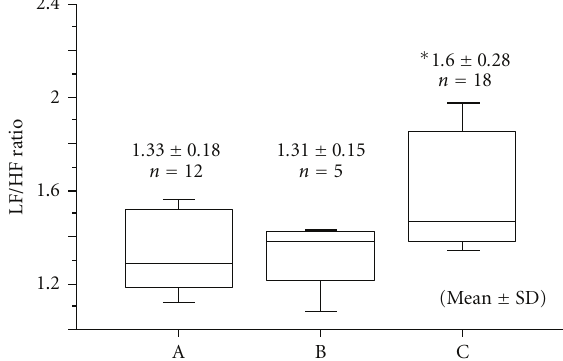
Figure 7: Intergroup changes in the low frequency/high frequency (LF/HF) ratio during normal pregnancy. Group (A): 28–31 weeks of pregnancy; Group (B): 32–35 weeks of pregnancy; Group (C): 36–40 weeks of pregnancy. ∗ One-way ANOVA: P = 0 . 003